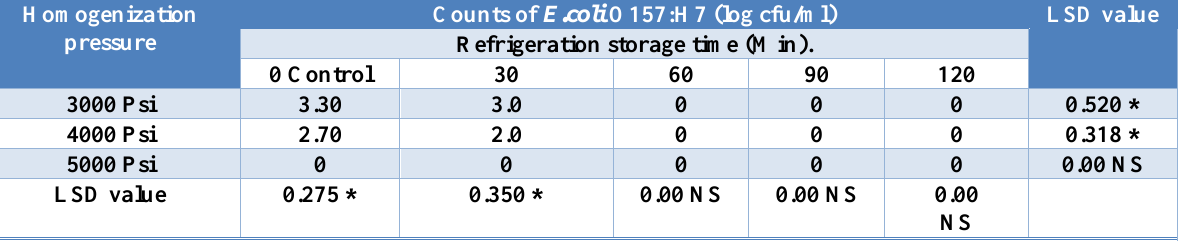
Table, 5: Effect of homogenization pressure (3000, 4000, 5000 psi) and bacterocin on viability of E. coli O157: H7 in